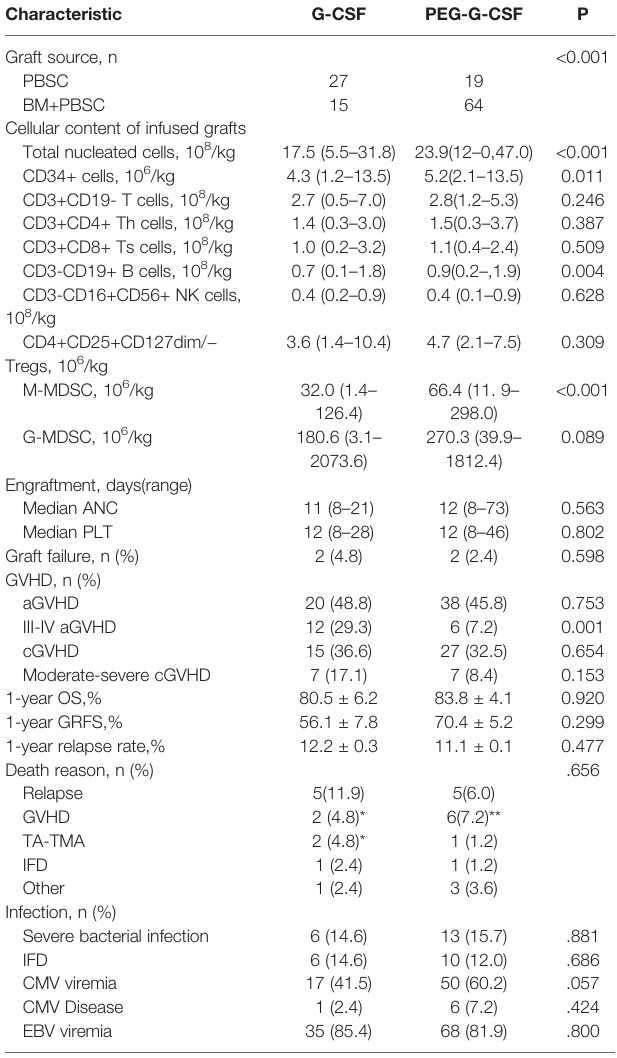
TABLE 5 | Engraftment and Transplantation Outcome.